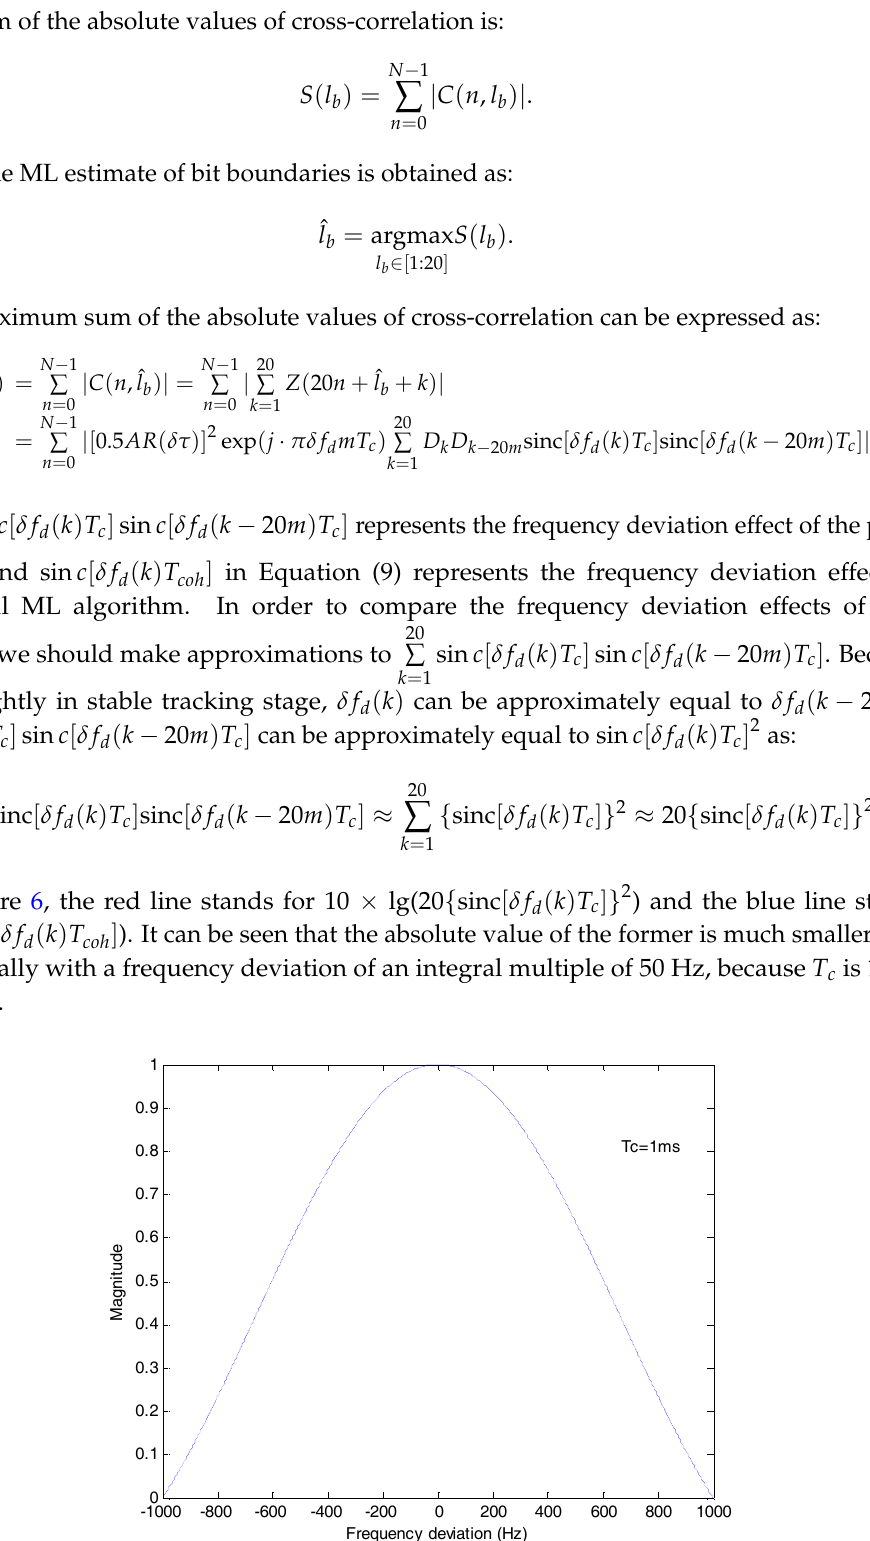
Figure 4. The amplitude attenuation of differential coherent algorithm due to frequency deviation. The integration time T c is 1